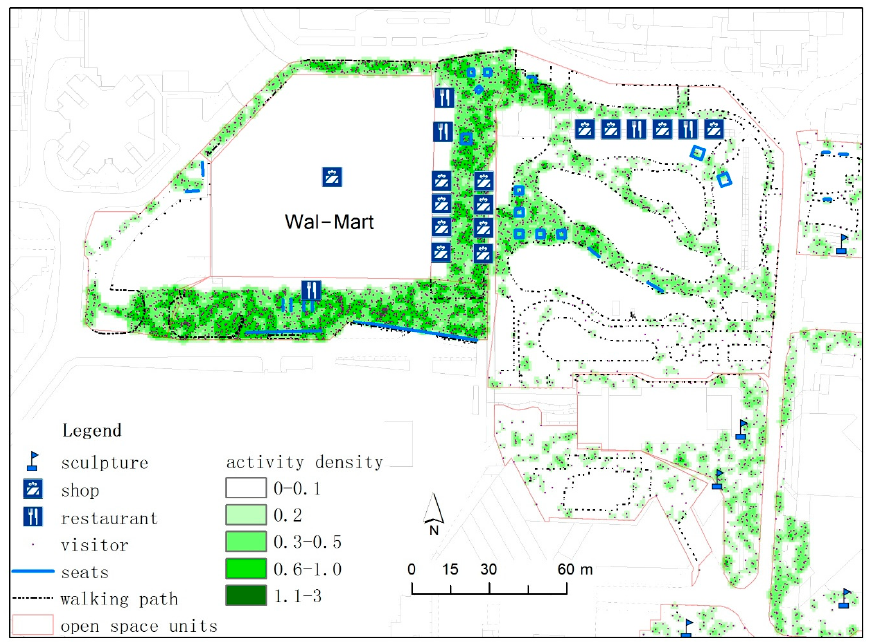
Figure 5. Map showing the activity density around Wal-Mart supermarket.